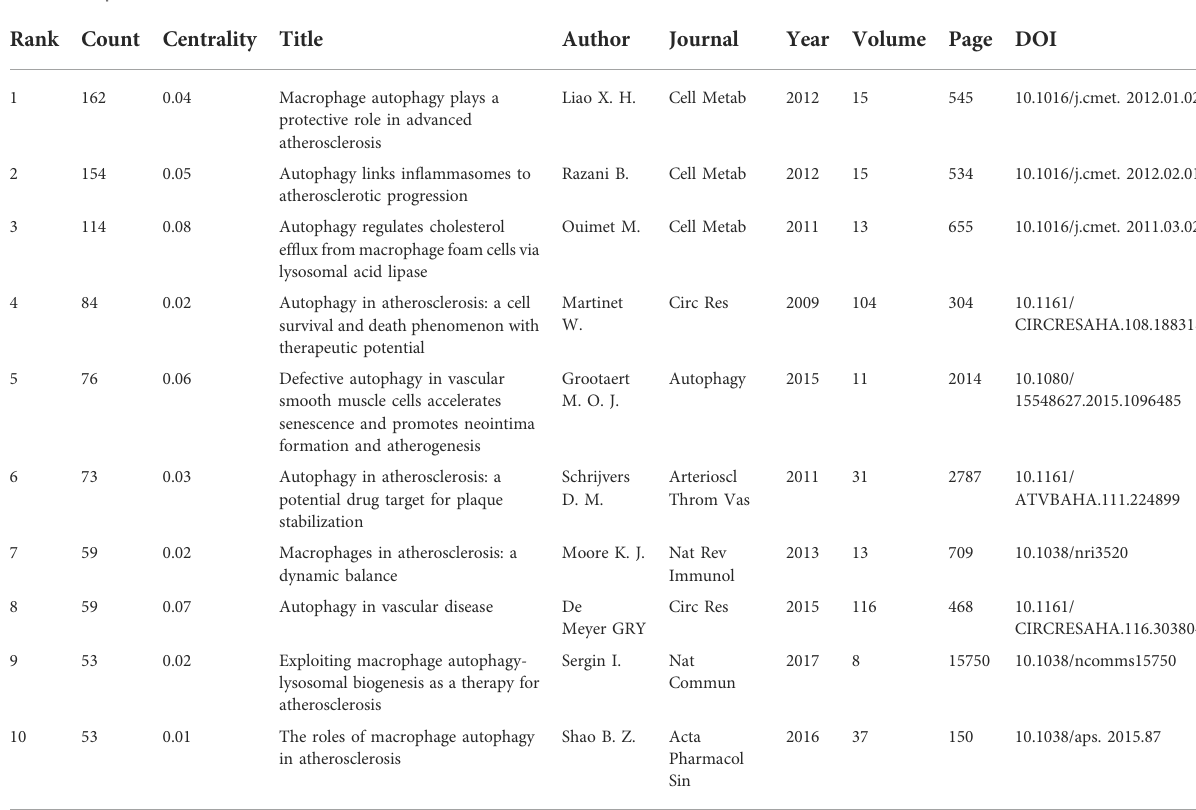
TABLE 8 Top 10 most cited literatures.